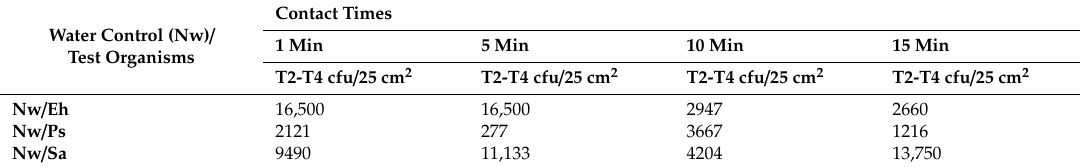
Table 3. The mean number of recovered bacteria (Eh = E. hirae , Ps = P. aeruginosa ; Sa = S. aureus ) on the test fields from T2 to T4 after wiping with water